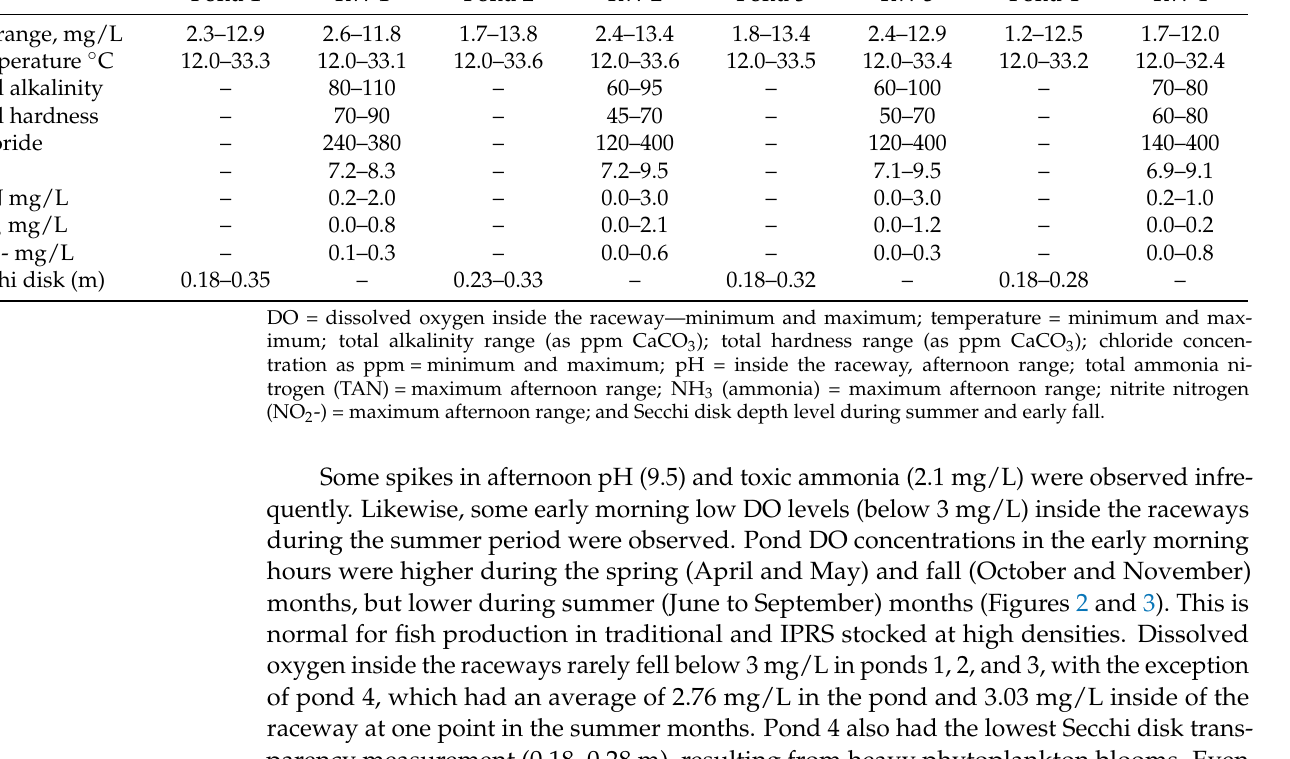
Table 3. Water chemistry results from within foodsize raceways and surrounding pond water when raising hybrid catfish (channel catfish Ictalurus punctatus